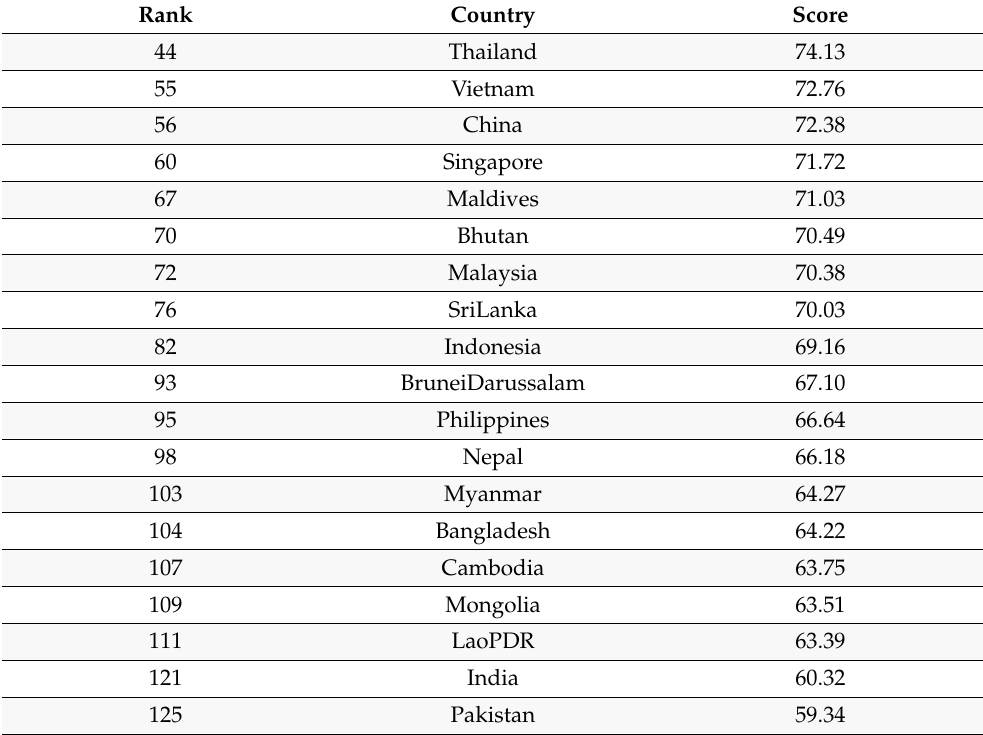
Table 1. Overall Score for Reaching Sustainable Development Goals.